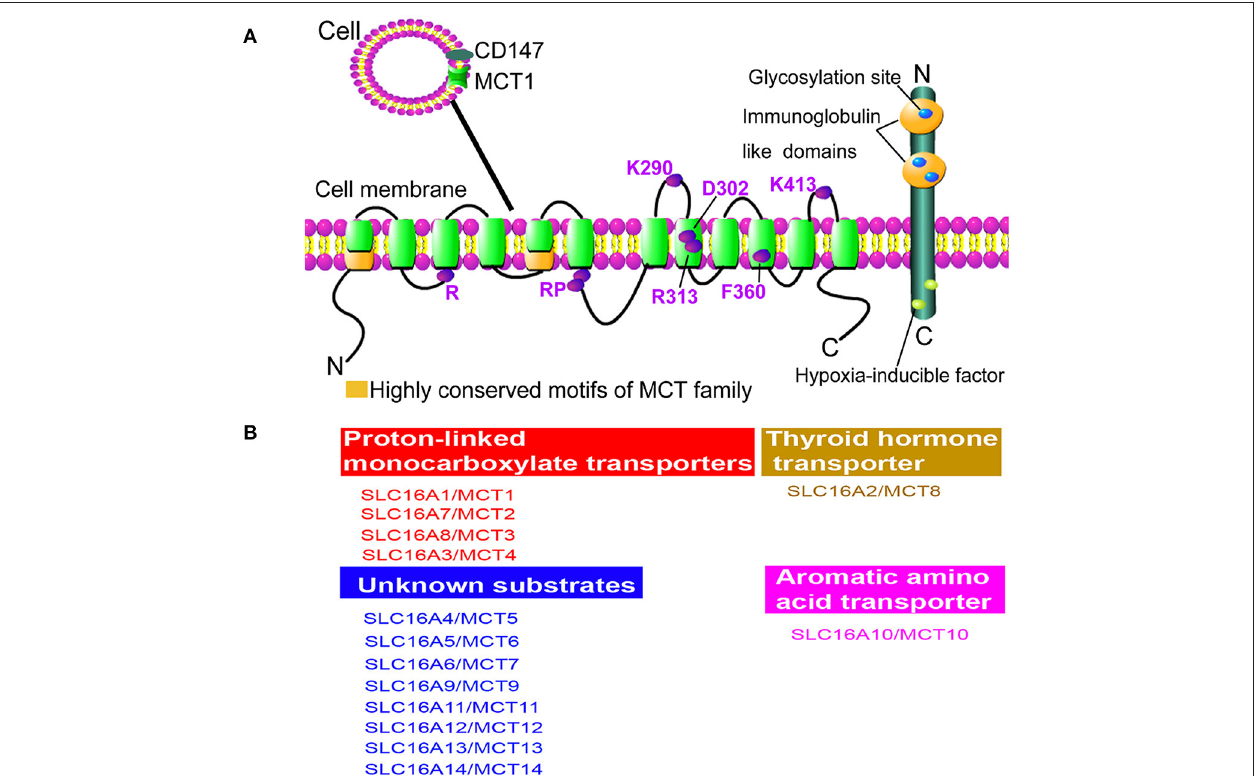
FIGURE 1 | Structure and function of monocarboxylate transporter (MCT) family. (A) The proposed topology of MCT family. There are 10–12 α -helical transmembrane domains (TMDs) for MCT family membranes in the presence of N- and C-termini located within cytoplasm. Besides, it shows the greatest variation at N- and C-termini and the large loop between TMDs 6 and 7 among family members, while the TMDs themselves are highly conserved. Importantly, two highly conserved motifs can be identified as the characteristic of the MCT family (green). Cluster of differentiation 147 (CD147) is an ancillary protein of MCT1 and MCT4, which is a cell surface glycoprotein containing a signal transmembrane span, two immunoglobulin-like domains in the extracellular region, and a short C-terminal cytoplasmic tail. The marked amino acids are significant for the structure conservation of MCT family. Specifically, R represents Arg; RP represents Arg and Pro; K290 represents Lys290; D302 represents Asp302; R313 represents Arg313; F360 represents Phe360; K413 represents Lys413; E218 represents Glu218. (B) Functions of MCT family members. MCT1, MCT2, MCT3, and MCT4 are proton-dependent transporters, which transport lactate, pyruvate, D- β -hydroxybutyrate, and acetoacetate ( 1). MCT8 can transport thyroid hormone and MCT10 is a transporter of aromatic amino acids, while the substrates of other MCT members are still unknown.